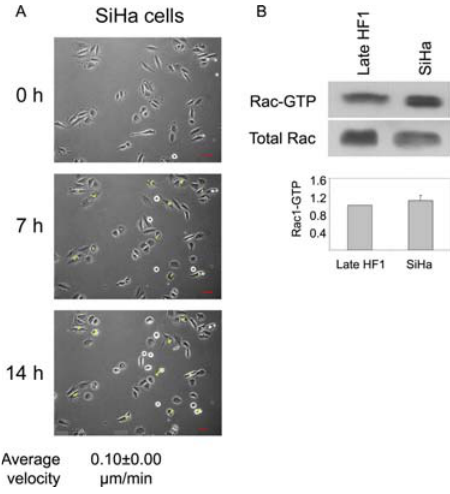
Figure 7. Migration and Rac1 activity in SiHa cells. A. Cell motility movies were created by acquiring live-cell images every 15 min throughout 14 h of the experiment. Cell tracks, in yellow, were determined by marking cell nuclei in every frame of the movie. The figure shows the same cells at the beginning of the experiment (0 h), after 7 h, and at the end of the movie (14 h). Cell velocity was calculated by marking the cell nucleus in every frame, and following cell movement. Average velocity was calculated by an application within the UCSF PRIISM environment ((http://msg.ucsf.edu/ive). Errors repre- sent standard error of . 200 cells. B. Western blot analysis of Rac1 in late HF1 cells and in SiHa cells. Upper panel shows activated, GTP-loaded Rac1 pulled-down with GST-PBD. Lower panel shows total Rac1 levels in whole cell lysates before pull down. Graph shows quantification of the active Rac1. Error bars represent standard errors of three independent experiments.